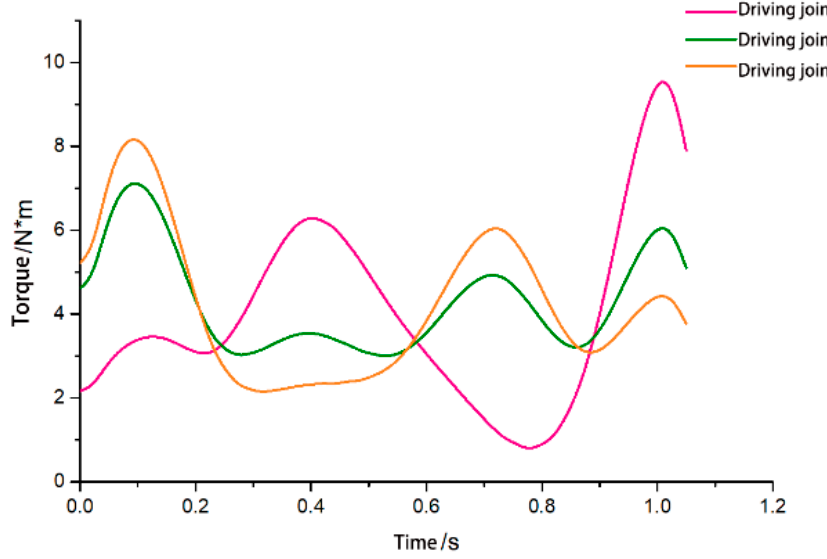
Figure 11. Plot of the angle, angle velocity, and angle acceleration of joint 3.